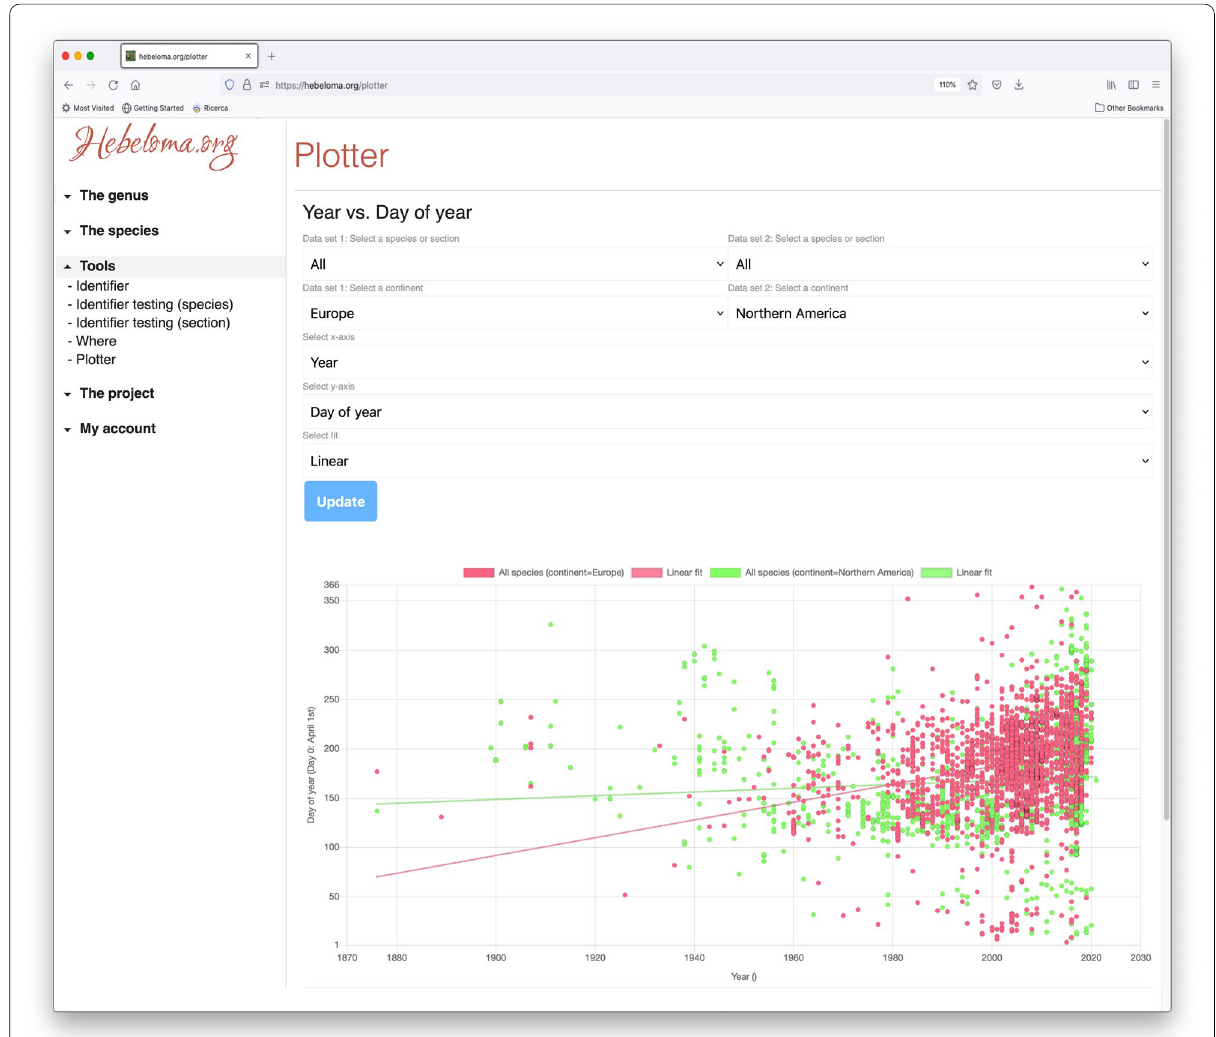
Fig. 2 Screenshot of the plotter input and output on https:// www. hebel oma. org/ plott er, showing the plot of the parameters “day of the year” against “year” for all collections from Europe (red) and Northern America (green). Arrows (downward) indicate fields where parameters for the plotter can be